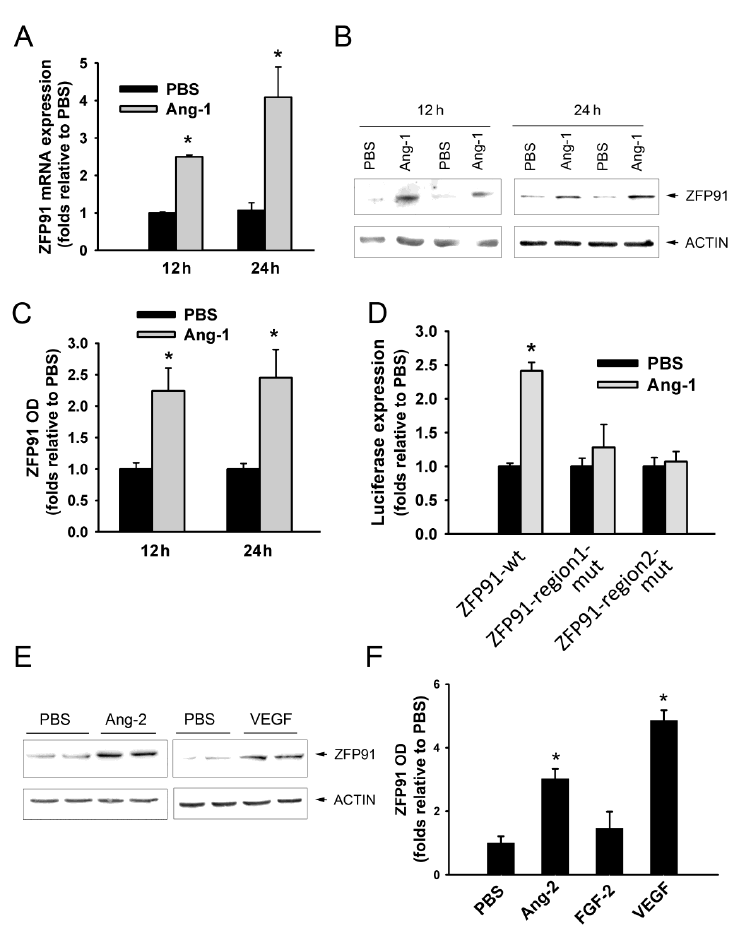
Figure 6. Regulation of ZFP91 expression by Ang-1. ( A ): Expression of ZFP91 mRNA in HUVECs exposed to PBS (control), or Ang-1 for 12, and 24 h. Values are means ± SEM, expressed as folds relative to PBS. * p < 0.05, compared to PBS. ( B and C ): Representative immunoblots and optical densities (OD) of ZFP91 protein in HUVECs exposed to PBS, or Ang-1 for 12, and 24 h. * p < 0.05, compared to PBS. ( D ): Relative luciferase activity in HUVECs transfected with luciferase reporter plasmid expressing wt or mutated 3’UTRs of ZFP91 then exposed to PBS, or Ang-1 for 24 h. * p < 0.05, compared to PBS. ( E and F ): Representative immunoblots and optical densities (OD) of ZFP91 protein in HUVECs exposed to PBS, Ang-2, FGF-2, or VEGF for 24 h. Values are expressed as folds relative to PBS. * p < 0.05, compared to